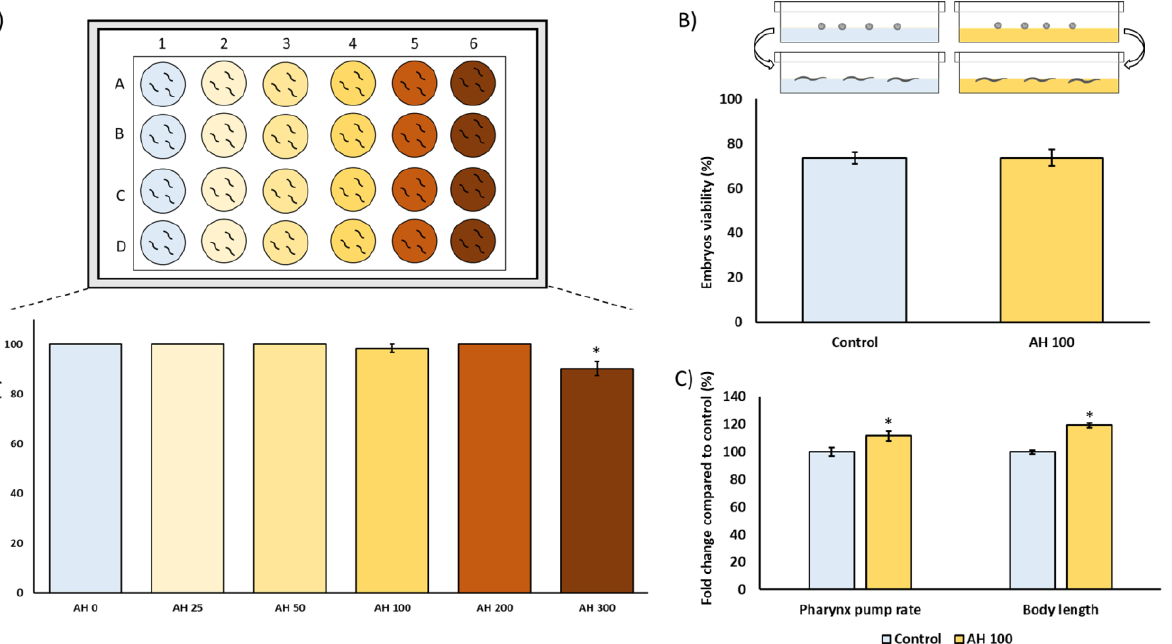
Figure 3. Toxicological characterization of avocado honey (AH) in the C. elegans N2-Wild type strain. ( A ) Short-term toxicity test. ( B ) Embryotoxicity evaluation. ( C ) Pharynx pump rate and body length analysis. Results are mean ± SEM. For each parameter, the asterisk (*) represents statistically significant differences with respect to the control ( p < 0.05). AH concentrations are shown as mg/mL.